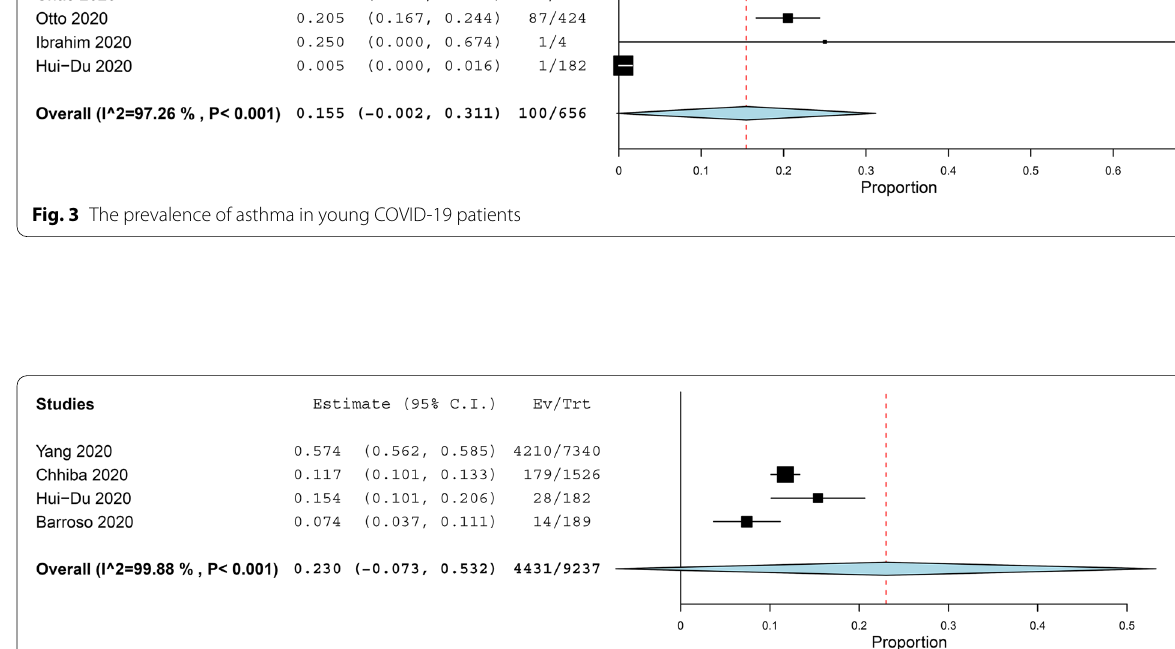
Fig. 4 The prevalence of allergic rhinitis in COVID‑19 patients